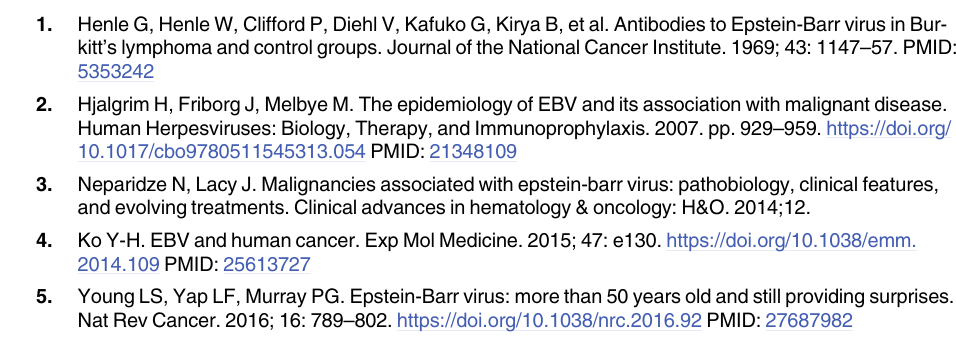
S3 Table. Significant Differential Tumor-Intrinsic Markers. Gene markers distinguishing the tumor cells between tumor types in the single cell RNA-Sequencing data, as identified by the “FindAllMarkers” function of the Seurat analysis package. Additional details are given at the top of the table. S4 Table. Dendritic Cell Signatures. Gene signatures derived from the literature for different subtypes of Dendritic Cells (DCs). These are used to subclassify the DCs identified in the single cell RNA-Sequencing